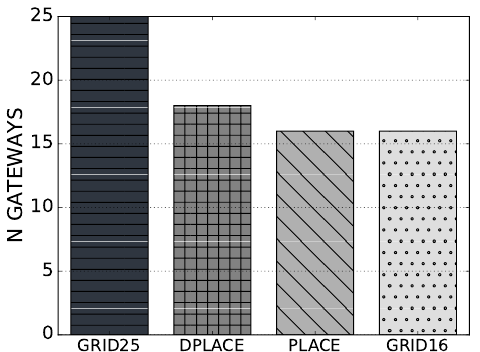
Figure 2. Number of Extended Range Wide Area Network (LoRaWAN) gateways for analyzed LoRaWAN gateway placement models.